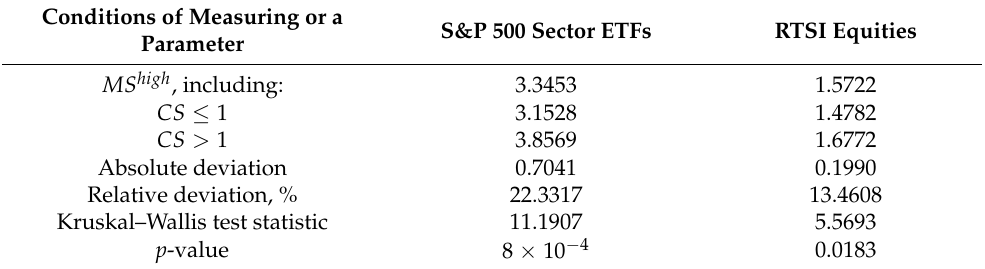
Table 4. Conditional mean value of risk on days following the days with atypical